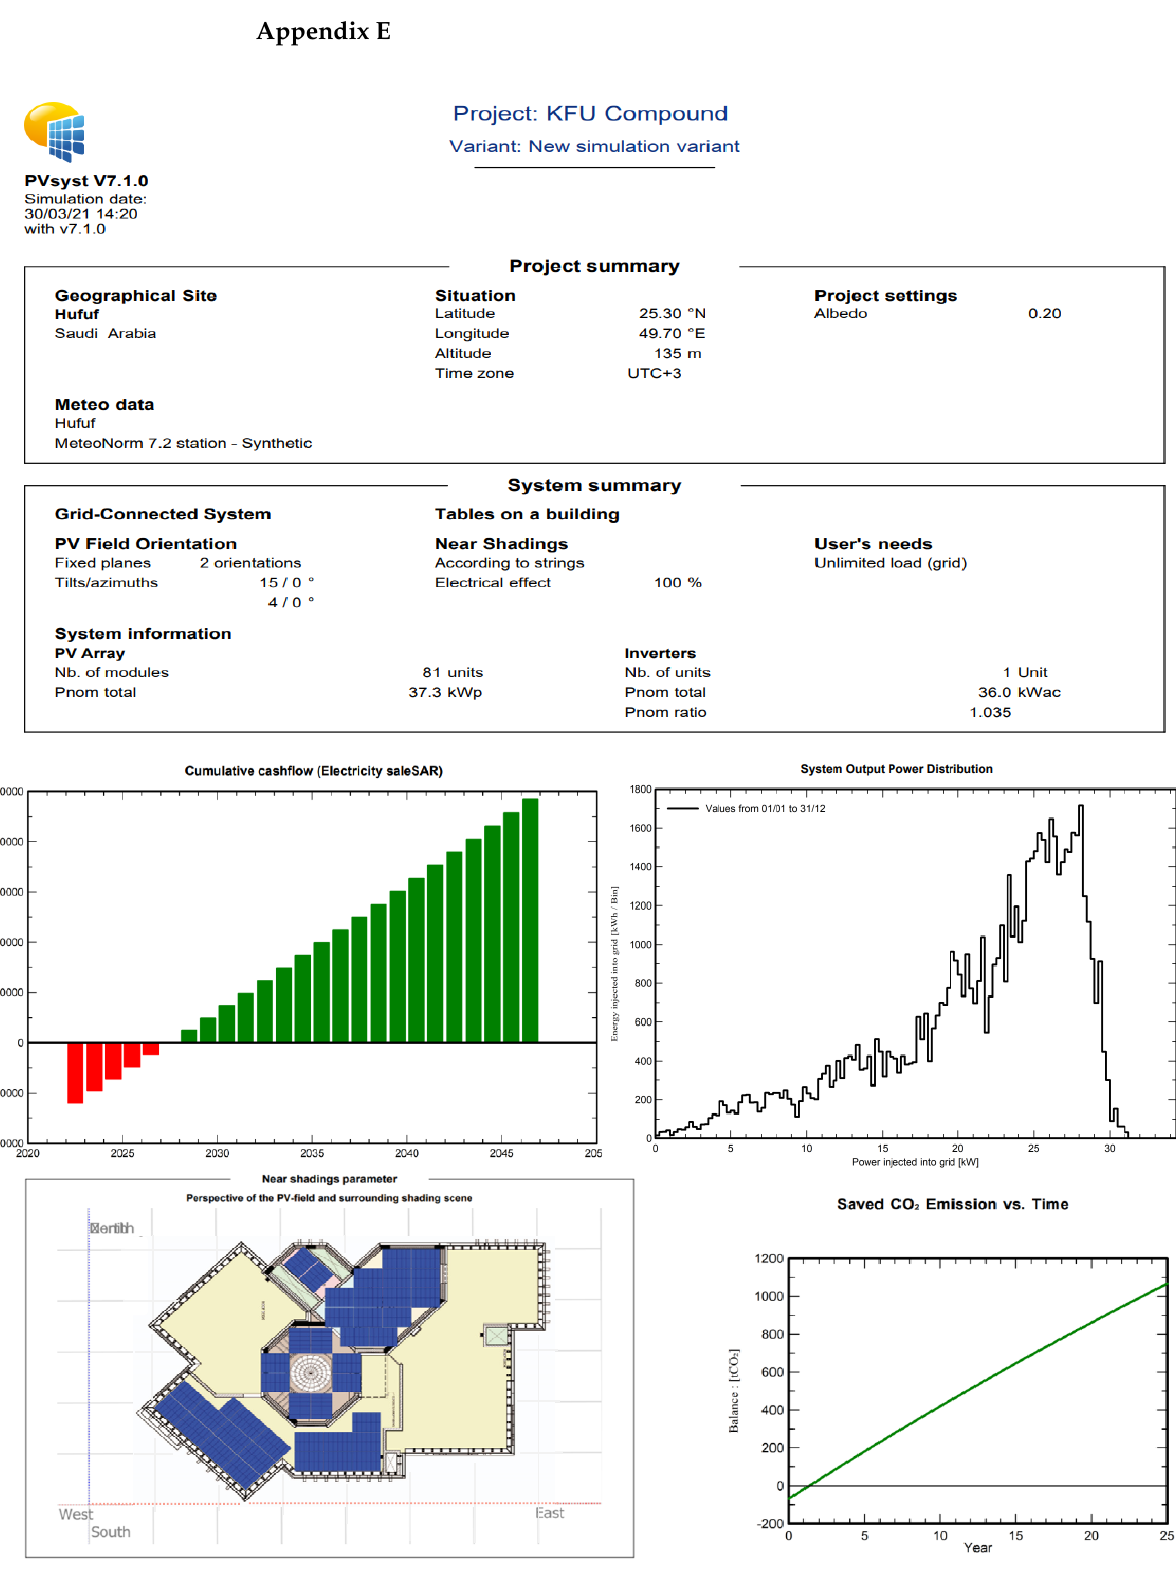
Figure A5. Project summary, output power distribution, cumulative cashflow, and CO 2 emissions from PVsyst V7.1.0 software for 181.5 m 2 PVT on roof area .